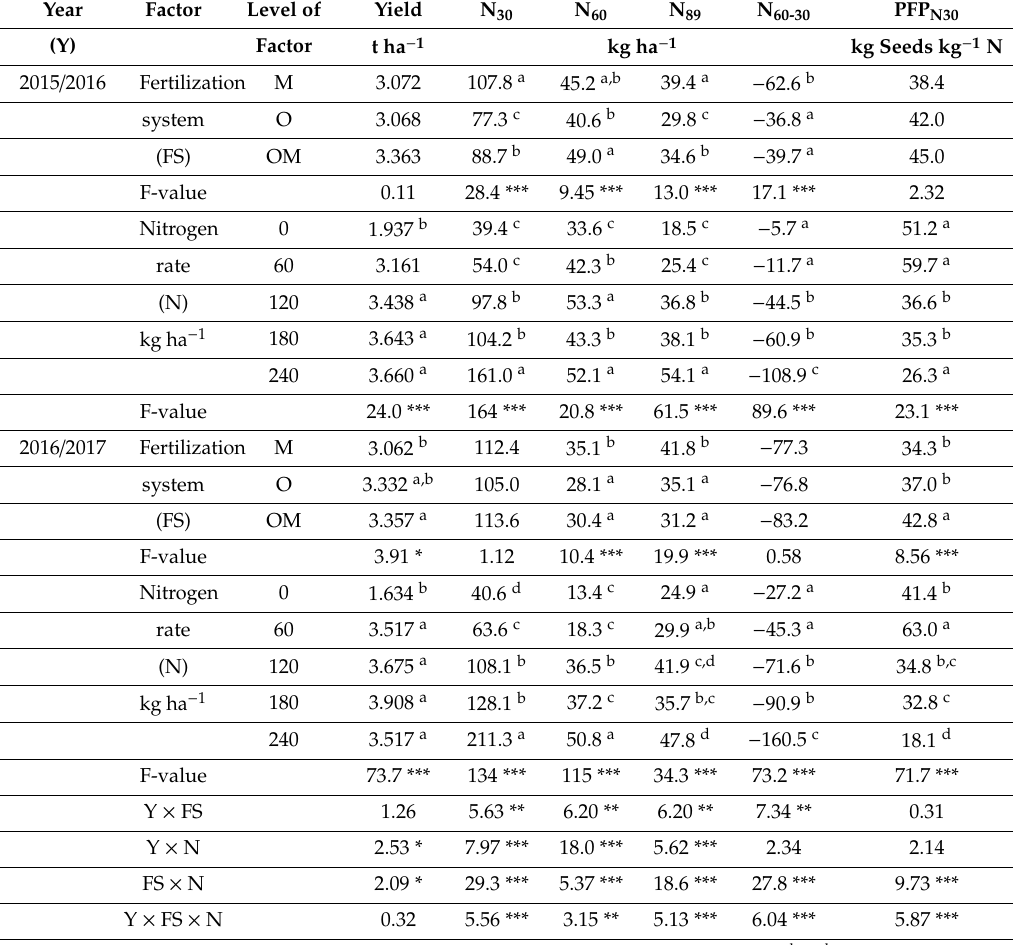
Table 3. In-season variability of the nitrate nitrogen content